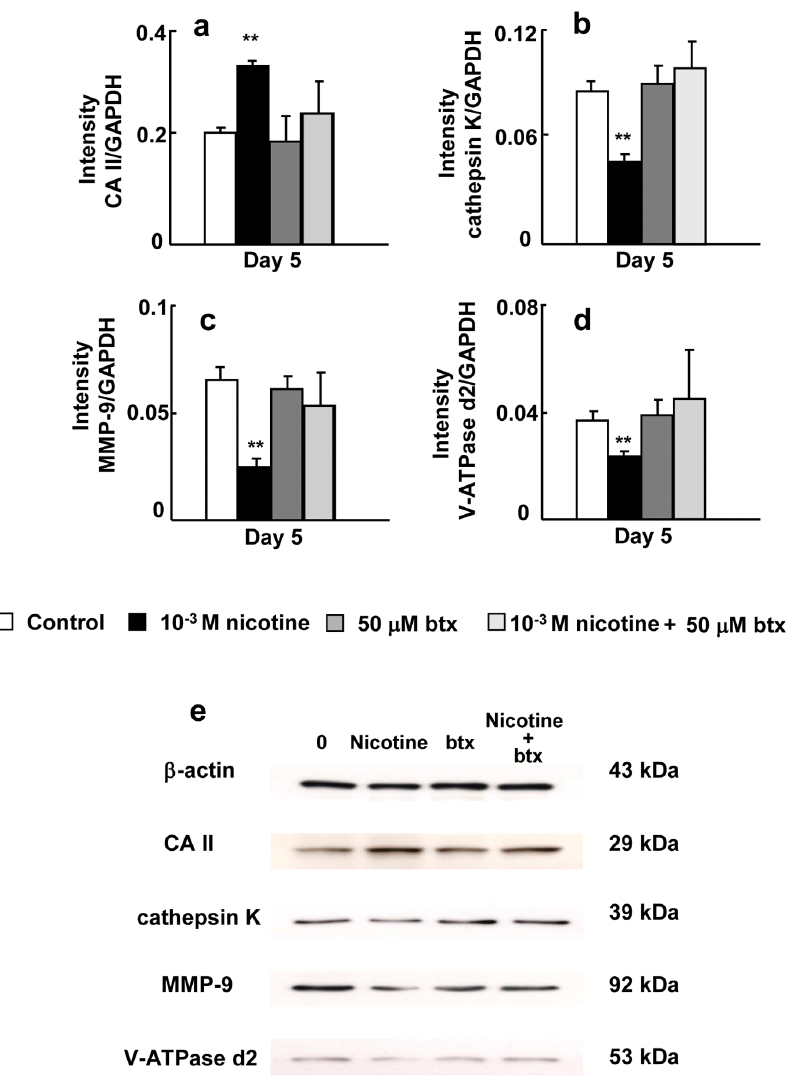
Figure 6. Effect of btx and/or nicotine on the expression of CA II, cathepsin K, and MMP-9 and V-ATPase d2. Bone marrow cells were cultured in medium containing macrophage colony-stimulating factor (50 ng/ml), and RANKL (50 ng/ml) without drug (control), 50 m M btx, 10 2 3 M nicotine, or 50 m M btx, and 10 2 3 M nicotine for 5 days. The mRNA expression of CA II (a), cathepsin K (b), MMP-9 (c), and V-ATPase d2 (d) was determined by real-time PCR. The protein expression of CA II, cathepsin K, MMP-9, and V-ATPase d2 was determined by Western blotting (e).Data are shown as the mean 6 S.D., n=3 independent experiments. *p , 0.05, **p , 0.01, nicotine treatment vs. control.